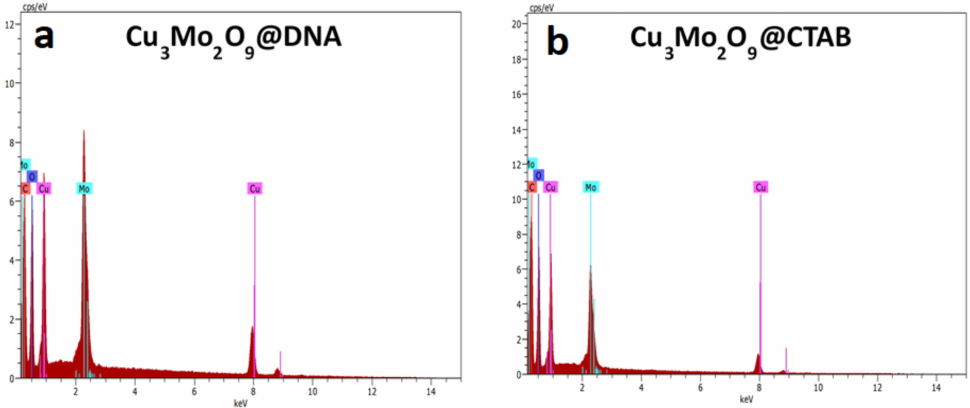
Figure 4. EDS spectra of ( a ) Cu 3 Mo 2 O 9 @DNA; ( b ) Cu 3 Mo 2 O 9